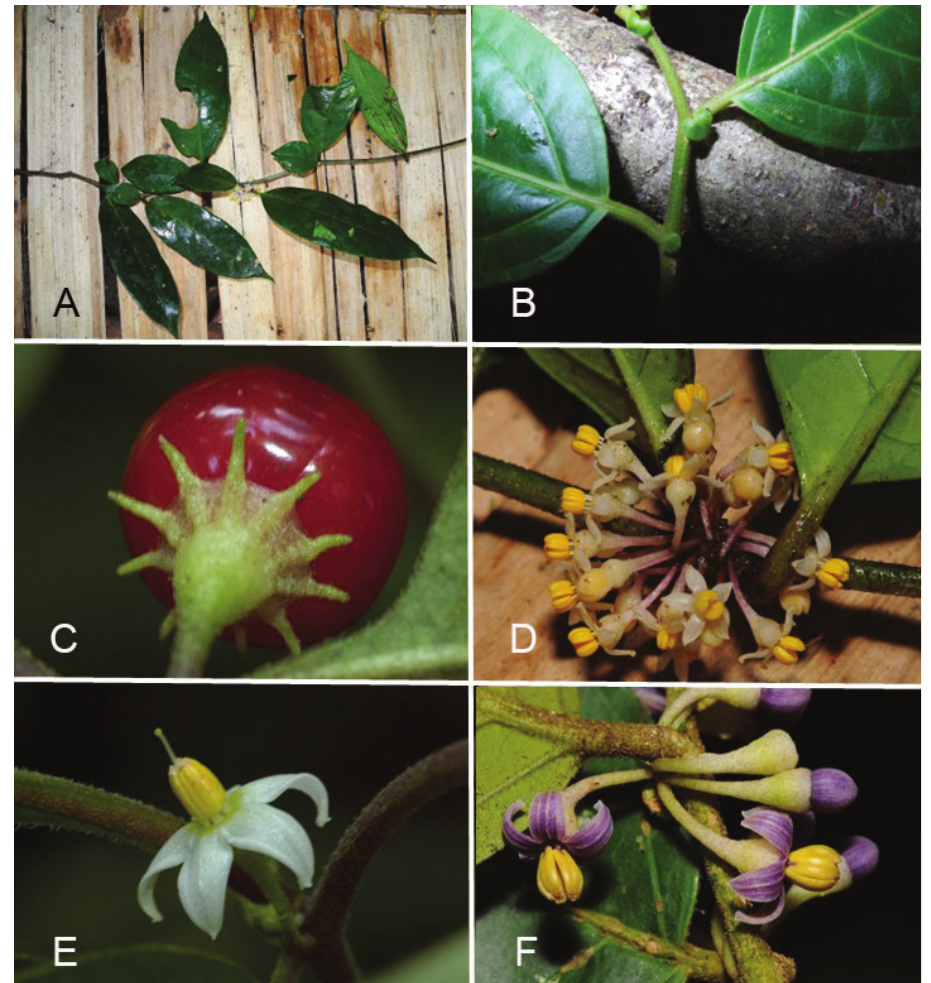
Figure 2. Representative morphology of Lycianthes A Lycianthes oliveriana with major and minor leaves differing only in size ( Damas et al. SAJ-1050 , Papua New Guinea) B Lycianthes cladotrichota with major and minor leaves differing markedly in size and shape ( James et al. SAJ-1385 , Papua New Guinea) C Lycianthes biflora in fruit with linear, awn-like calyx appendages ( Knapp 10106 , Yunnan, China) D Lycianthes oliveriana with urceolate calyces with no appendages ( Damas et al. SAJ-1050 , Papua New Guinea) E Lycianthes biflora with stellate corollas and membranous lobes ( Knapp 10106 , Yunnan, China) F Lycianthes cladotrichota with stellate corollas and thick, fleshy lobes (short-styled plant, James et al. SAJ- 1385 , Papua New Guinea). Photograph credits: A, B, D, F Shelley James; C, E Sandra